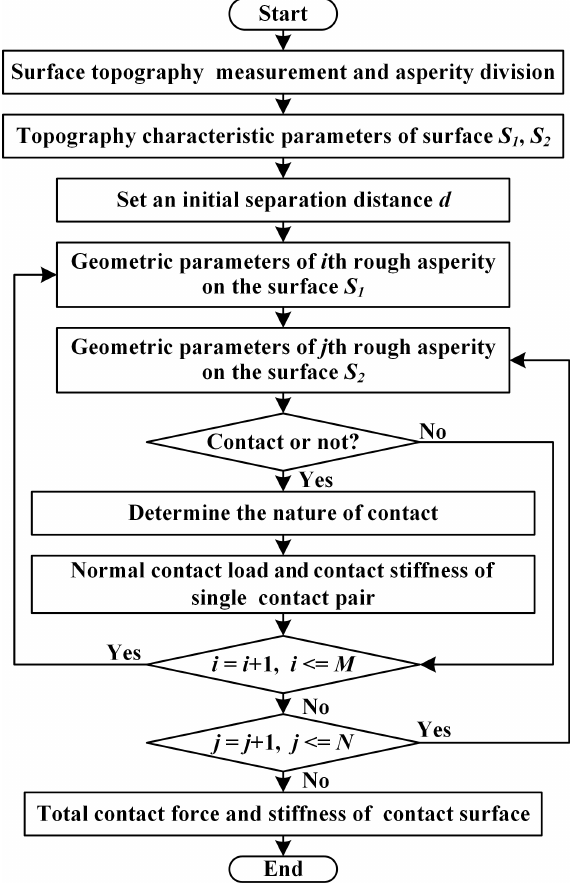
Figure 5. Flow chart for calculating the contact stiffness between two rough